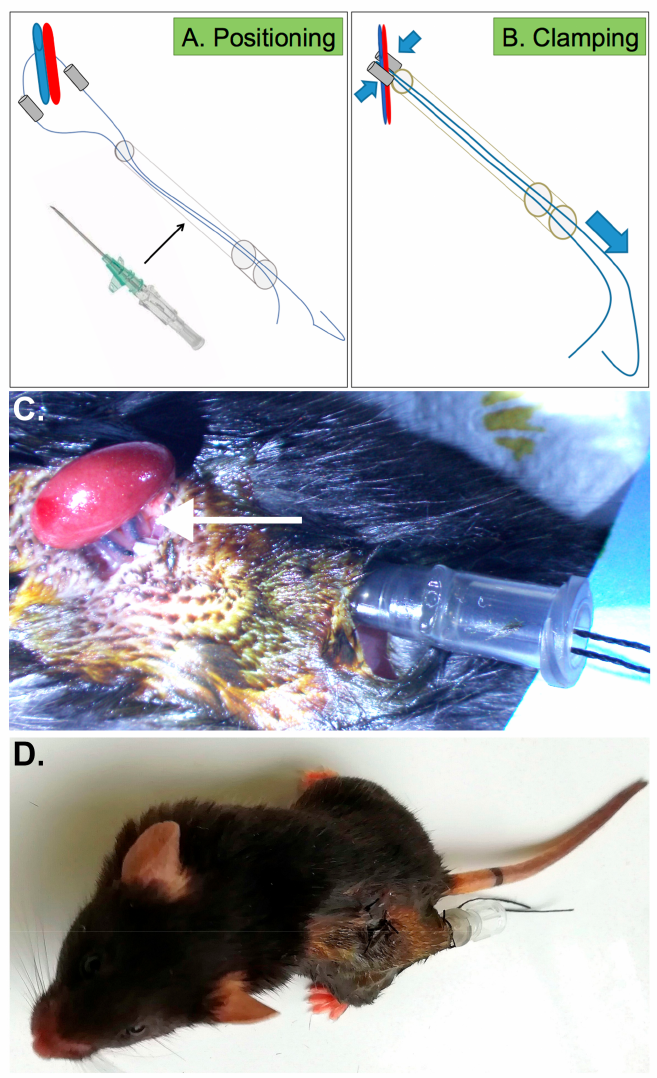
Figure 1. The repeated ischemia-reperfusion injury (RIRI) clamping device. ( A , B ) Schematic represen- tation of the RIRI clamping device in the open ( A ) and closed ( B ) positions. ( C ) Representative image of the thread/silicone tubings positioned around the renal vascular pedicle (arrow), the extremities of which are inserted into a 16 G (grey) catheter. ( D ) A conscious mouse with the RIRI clamping